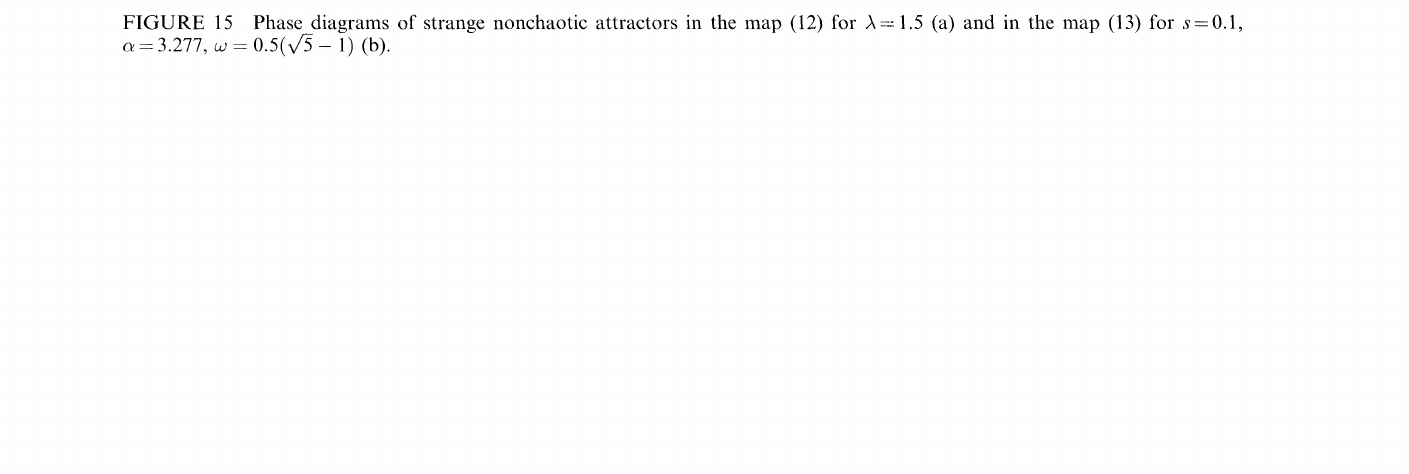
= 1.5 (a) and in the map (13) for s--0.1,